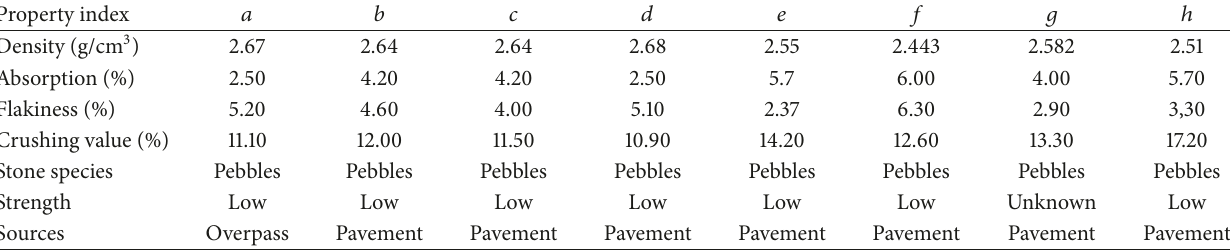
Table 3: Property data of RA from